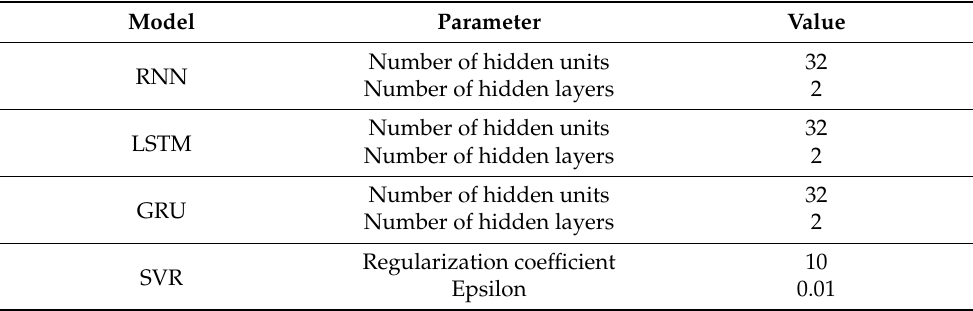
Table 7. Main parameters of the compared prediction methods.